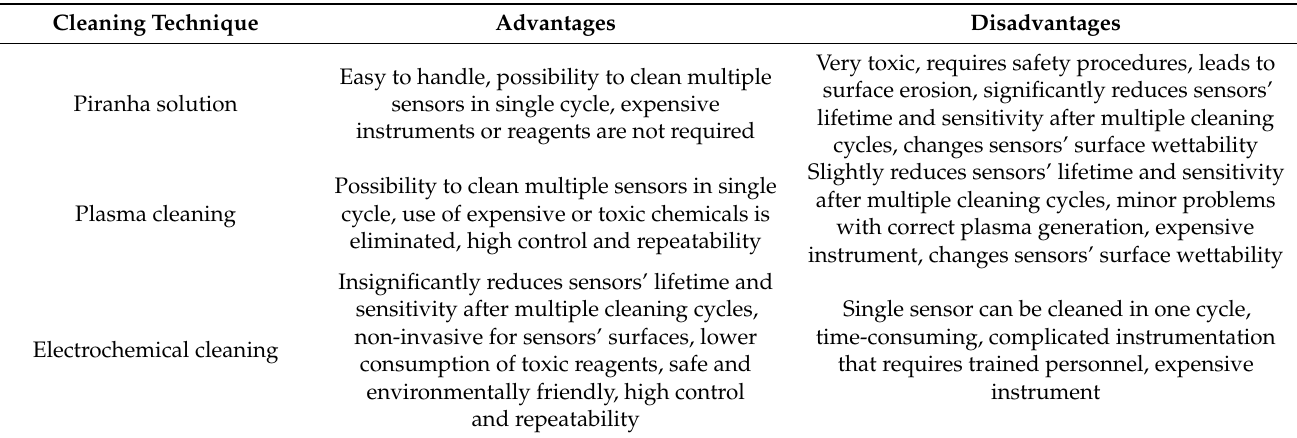
Table 4. A summary of the advantages and disadvantages of methods used in this study to clean